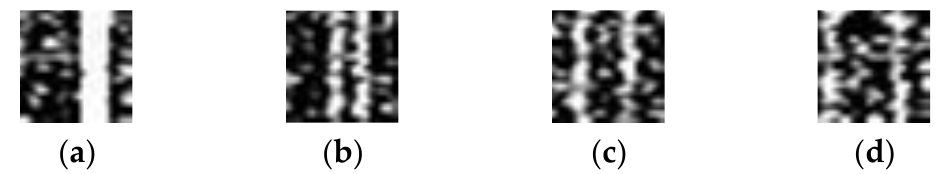
Figure 26. Partial 20 × 20 sample graph with target under the condition of 0 dB SNR, and the two scattering points with a distance of ( a ) 0.15 m, ( b ) 0.3 m, ( c ) 0.6 m, and ( d ) 0.9 m.